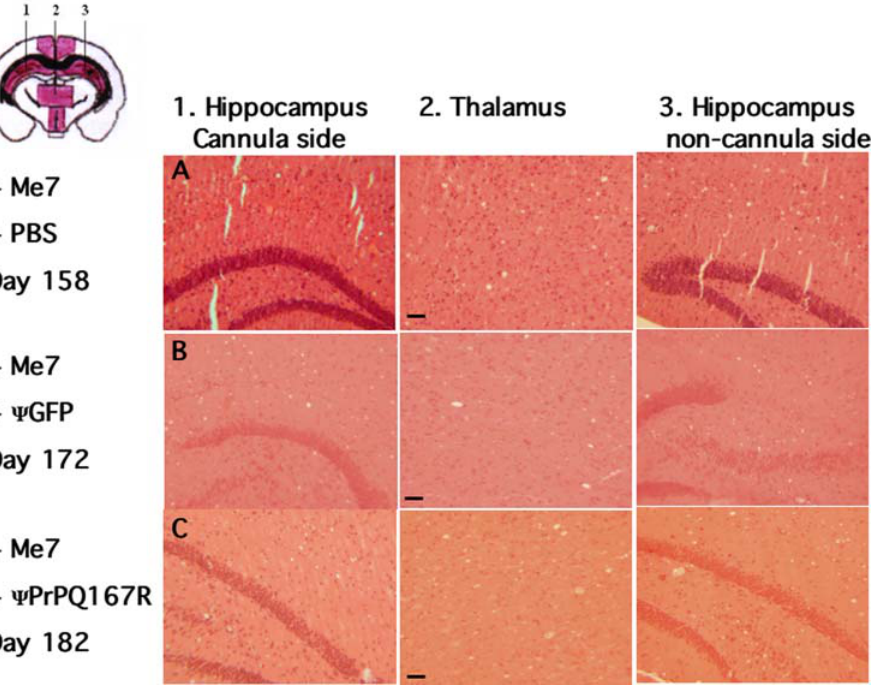
Figure 4. Histological analysis of brain tissue sections. All the tissue sections were stained with hematoxylin and eosin and examined histologically to confirm prion pathology as evidenced by the presence of vacuoles. The plus ( + ) signs indicate that the mice were inoculated with the ME7 prion strain. Mice received two injections of either PBS (row A), lentivirus carrying the GFP gene (row B), or lentivirus carrying the PrPQ167R gene (row C). Frontal tissue sections selected in the panel correspond to the numbers indicated in the schema on the top left. Coloured areas in the schema correspond to anatomical sites referenced for the establishment of vacuolization profiles. Pathological analysis was performed on three independent brains from each category of mice. Bar, 21 m m.